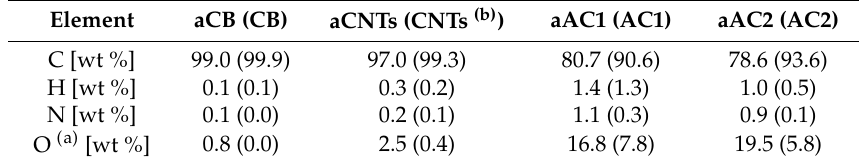
Table 1. Results of the Elemental Analysis (EA) of oxidized and non-oxidized carbon materials.